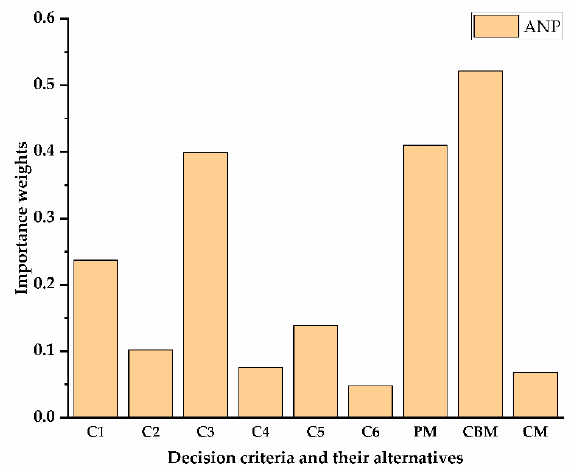
Figure 9. Final weights of decision criteria and alternatives.